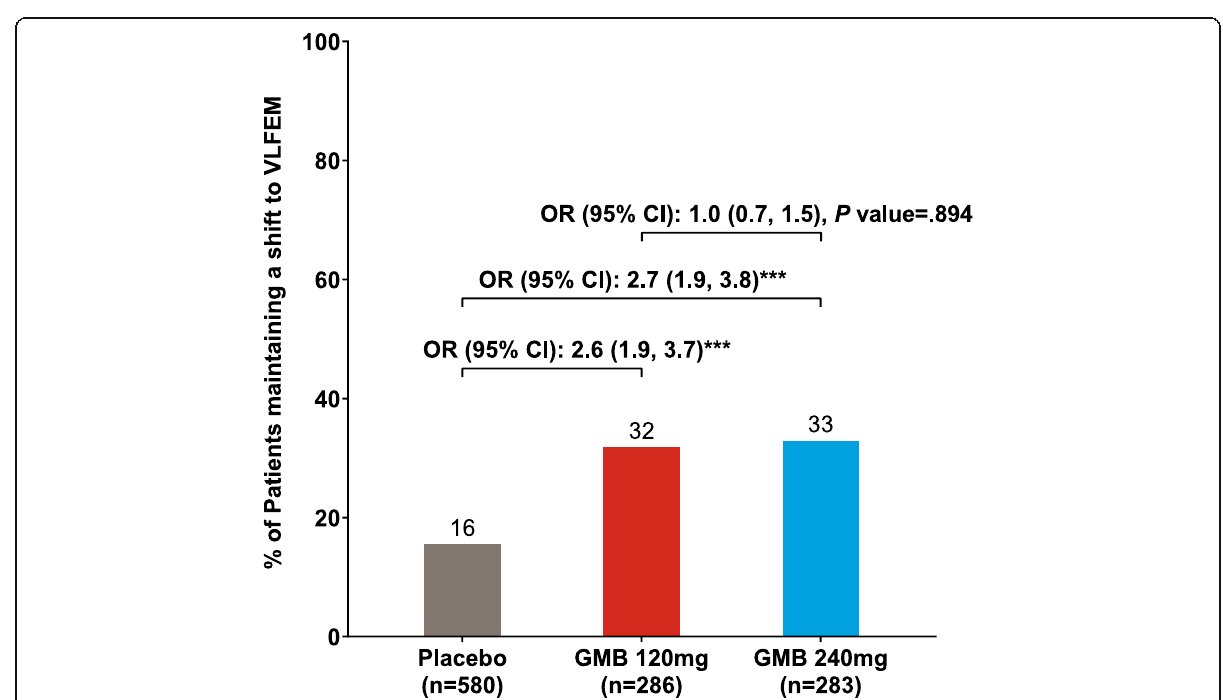
Fig. 3 Percentage of patients shifting from HFEM to VLFEM status anytime during the double-blind treatment period and maintaining their shift from HFEM status to VLFEM status for ≥ 3 consecutive months until the end of the study (patients with HFEM at baseline). *** P < .001 versus placebo from logistic regression analysis. Abbreviations: CI, confidence interval; GMB, galcanezumab; HFEM, high-frequency episodic migraine; n, number of patients who were categorized as HFEM at baseline with a baseline value and at least one post-baseline value recorded; OR, odds ratio; VLFEM, very low-frequency episodic